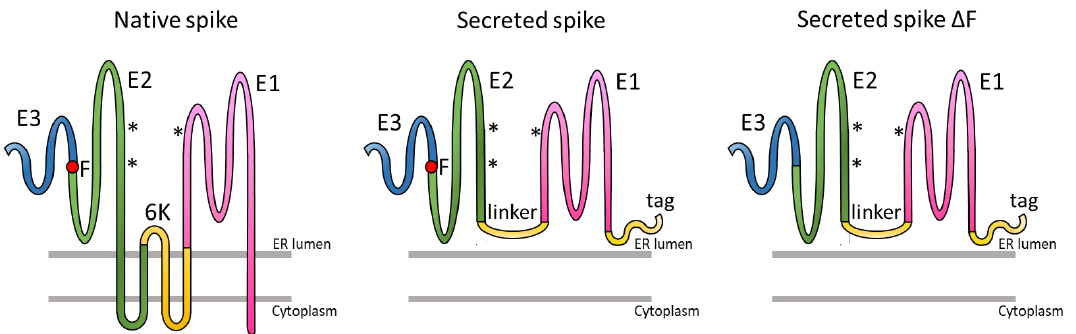
Figure 1. Native and secreted spike heterodimer precursors. The native spike heterodimer precursor, E3-E2-6K-E1, is anchored in the endoplasmic reticulum (ER) membrane and contains a furin cleavage site (F) between E3 and E2. Secreted spikes are formed by connecting the CHIKV E3E2 and E1 ectodomains with a glycine–serine linker to replace the E2 transmembrane domain and 6K. The C-terminal E1 transmembrane domain is replaced by a Strep-tag II (tag) sequence. The secreted spike furin cleavage site mutant (ΔF) has a disrupted furin cleavage site (F) preventing cellular furin cleavage of E3. Asterisks indicate N-glycosylation sites.